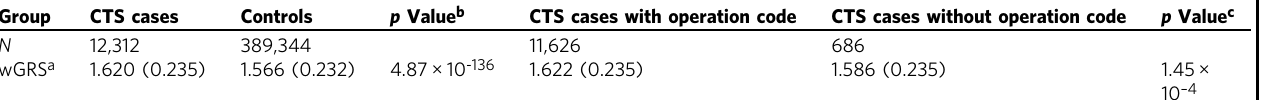
CTS carpal tunnel syndrome, wGRS weighted genetic risk score a Standard deviation shown in parentheses b Unpaired two-tailed t test between CTS cases and controls c Unpaired two-tailed t test between CTS cases with operation code and CTS cases without operation